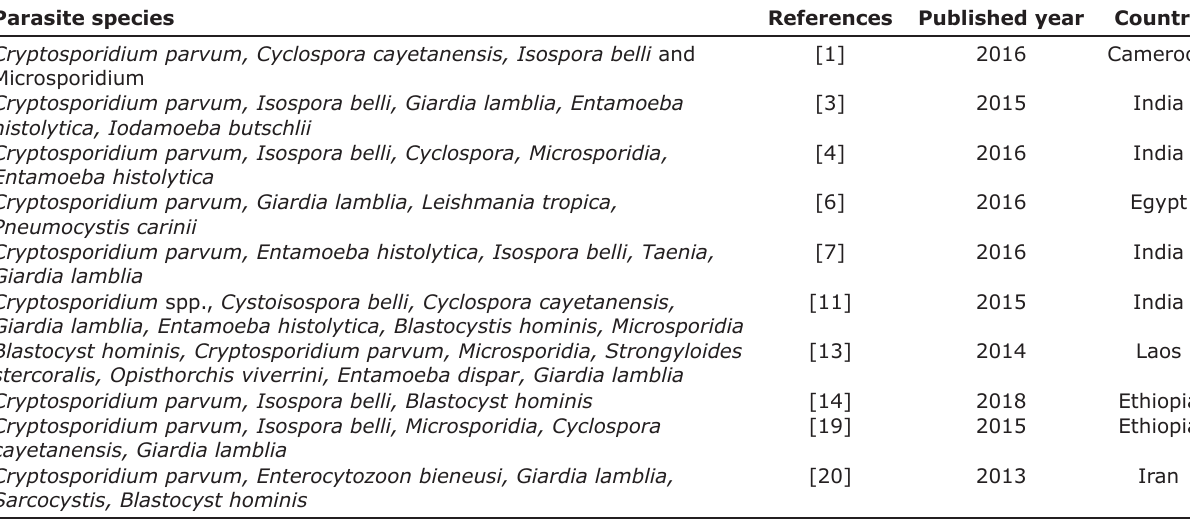
Table-1: Different protozoal agents in diarrheal disease based on geographical regions. Parasite